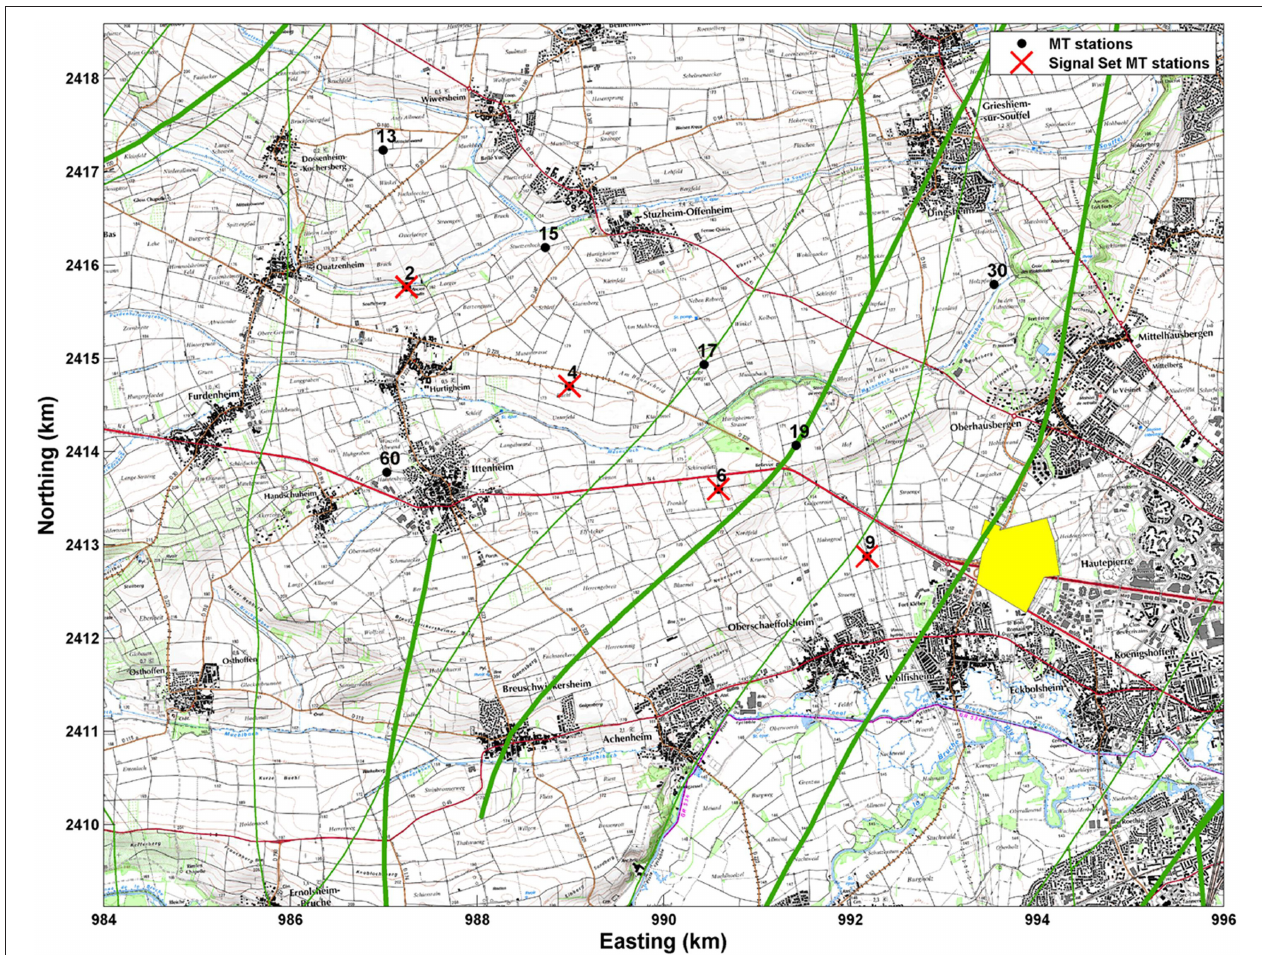
FIGURE 6 | Map of the MT stations deployed on the western side of Strasbourg. Black dots: complete station set. Red crosses: “local” station inserted in the SignalSet object. Green lines: major geological faults. Red line: seismic profile. Yellow area: geothermal plant area.